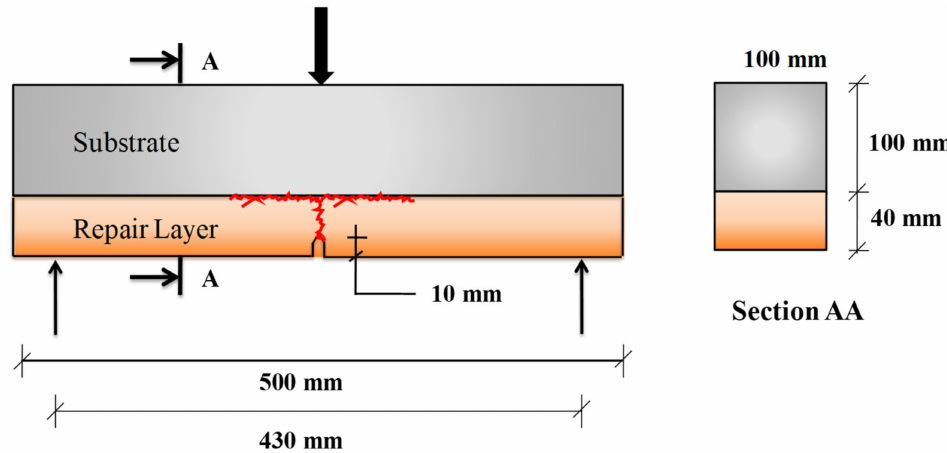
Figure 6. Schematic representation of tested specimen for use in bending